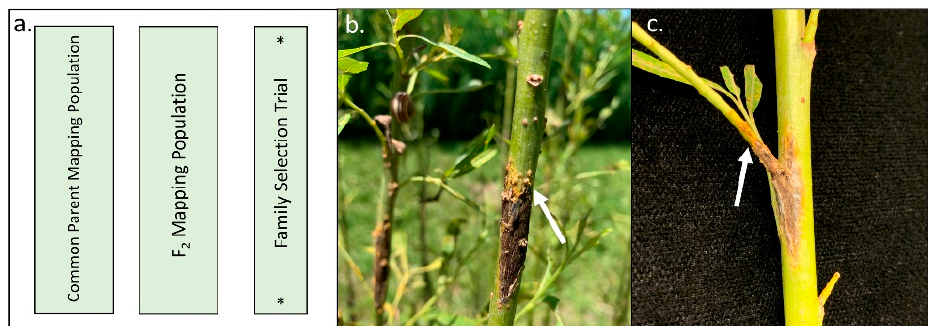
Figure 1. Trial proximity and photos of stem cankers observed in 2020. ( a ) Schematic of three neighboring fields for which M. paradoxa rust was collected, (*) indicates field where cankers were observed. ( b ) Image of stem canker on Salix purpurea × S. suchowensis shoot in 2013 Family Selection Trial. Image of stem cutting containing a canker lesion collected from the field. ( c ) Image of stem cutting containing a canker lesion collected from the field. Arrows indicate stem rust uredospore pustules at the margins of lesions.